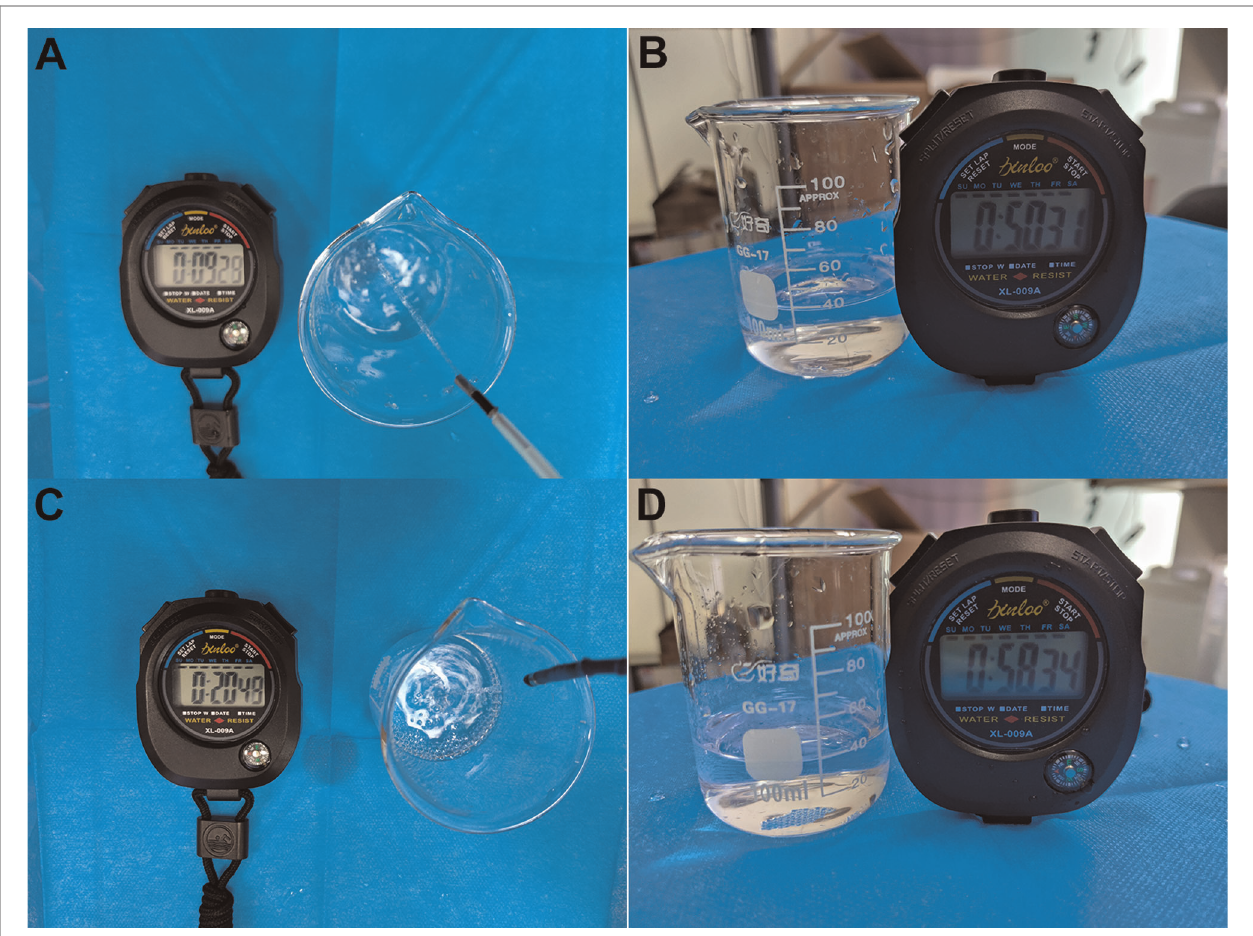
FIGURE 4 | Comparison of water injection rates. ( A ) Water Injection by Disposable Super fi ne Catheter for Visual Examination of Bile and Pancreatic Ducts, ( B ) Time of 40 mL Water Injection by Disposable Super fi ne Catheter for Visual Examination of Bile and Pancreatic Ducts, ( C ) Water Injection by SpyGlass ™ DS, ( D ) Time of 40 mL Water Injection by SpyGlass ™